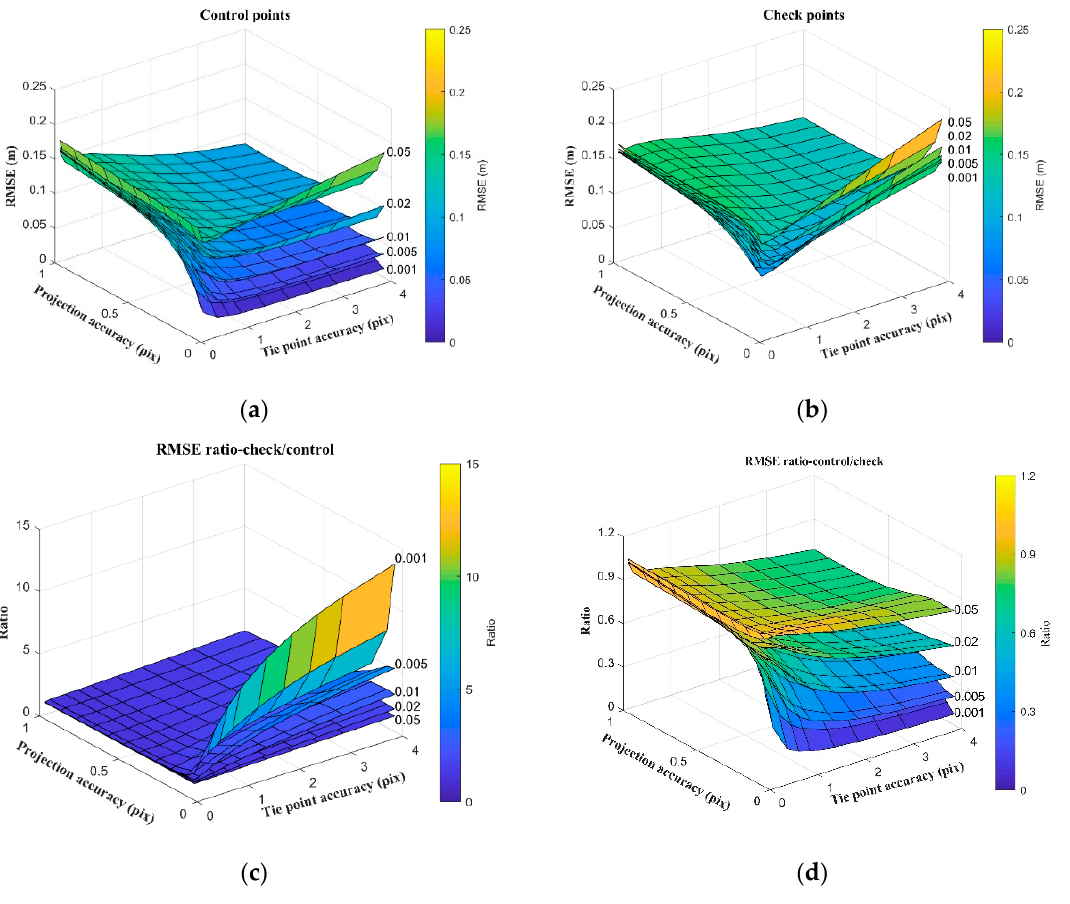
Figure 2. RMSE distribution results. ( a ) RMSE of the control points; ( b ) RMSE of the check points; ( c ) RMSE ratio of checkpoints to control points; ( d ) RMSE ratio of control points to